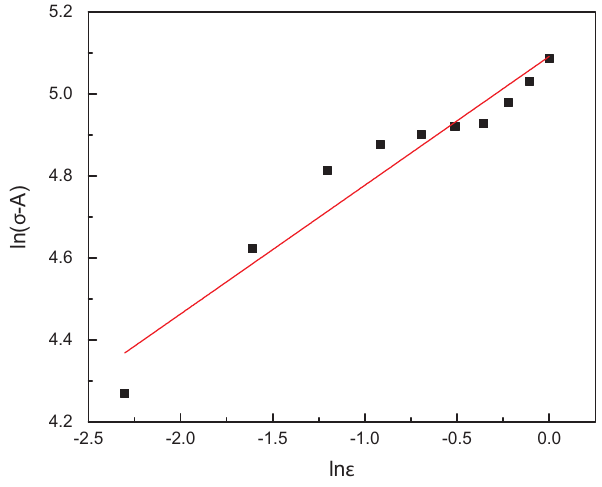
Figure 3: Relationship between ln( σ − A ) and ln ε at 933 K and 1 s − 1